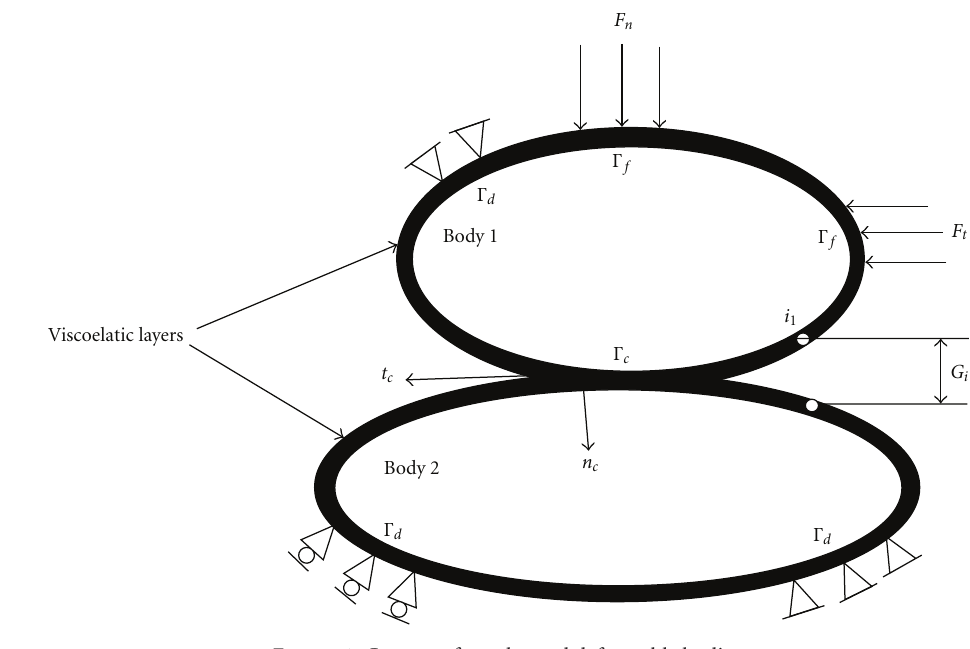
Figure 1: Contact of two-layered deformable bodies.